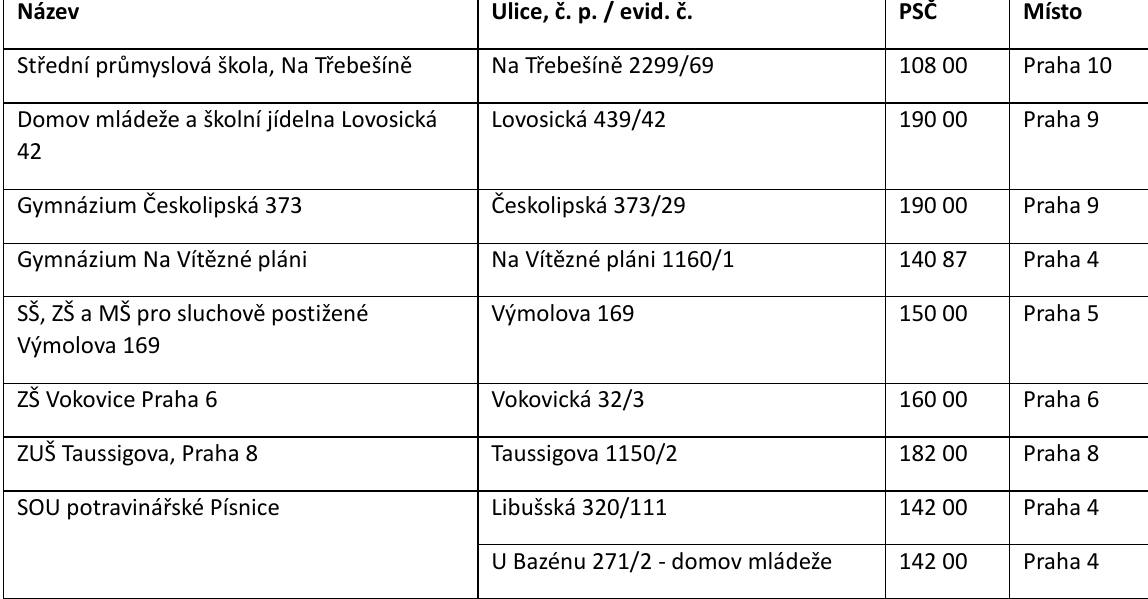
Tab 2: Školy (primární a sekundární vzdělávání) Název Místo